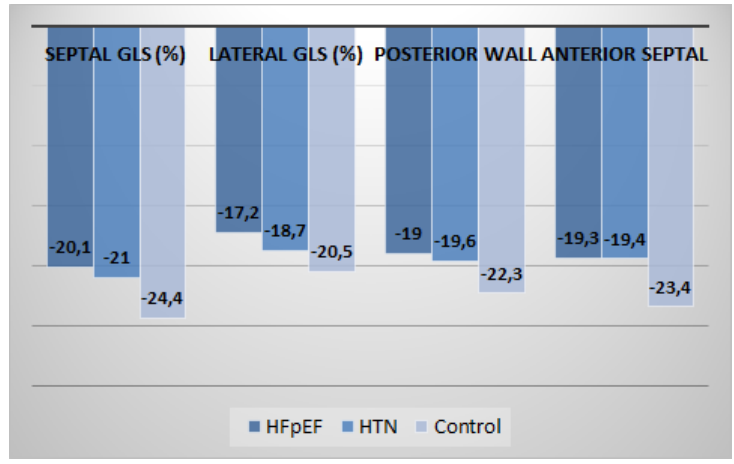
Figure 6. Distribution of mean regional LS values at apical level between the three groups ( n = 148).